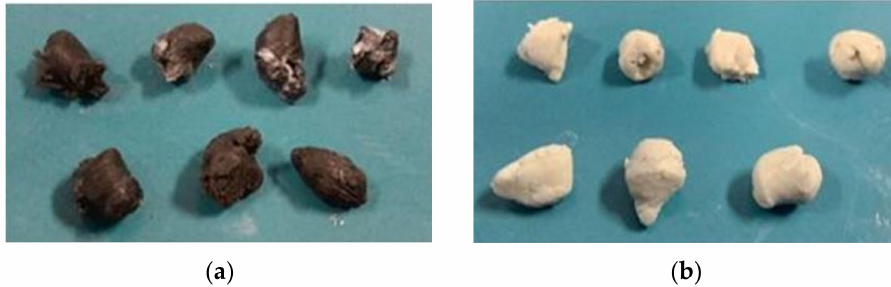
Figure 13. Cut-off bridges between balls during rolling: ( a ) black plasticine; ( b ) white plasticine.